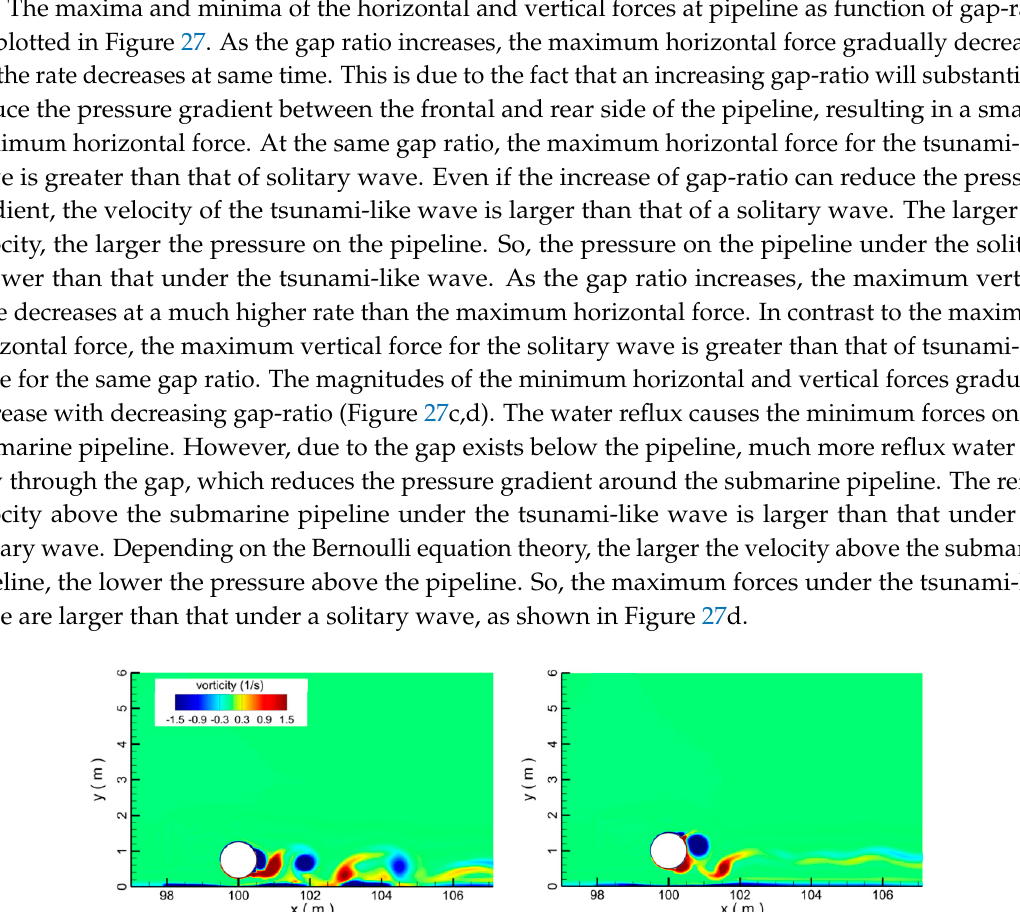
( b ) Figure 26. Temporal evolution of hydrodynamic forces at a pipeline when the gap-ratio equals 0.25; ( a ) horizontal force F x * ( b ) vertical force F z *.